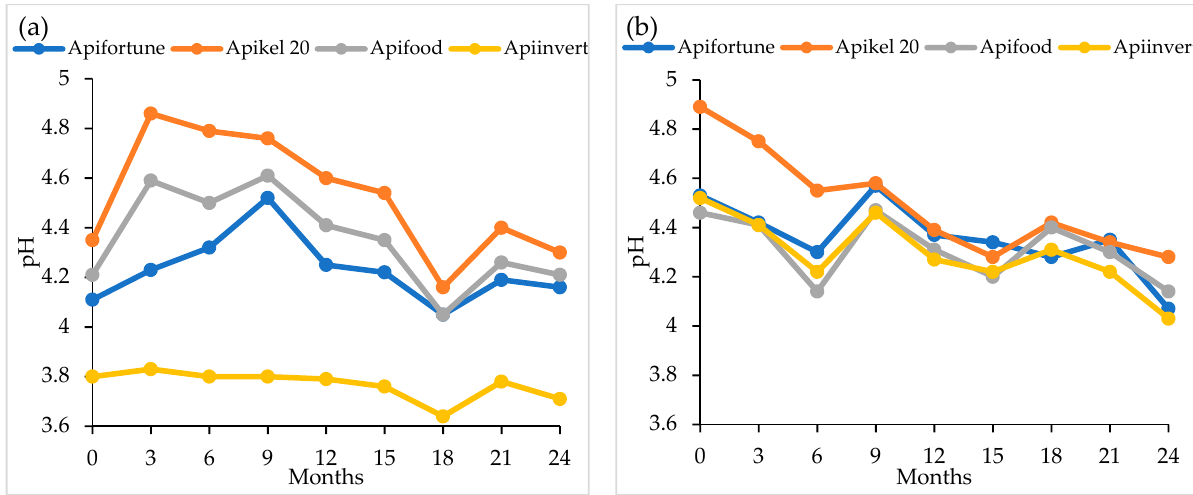
Figure 18. Changes of pH of syrups during storage at 10–14 °C ( a ) from 2012 and ( b ) from 2013.